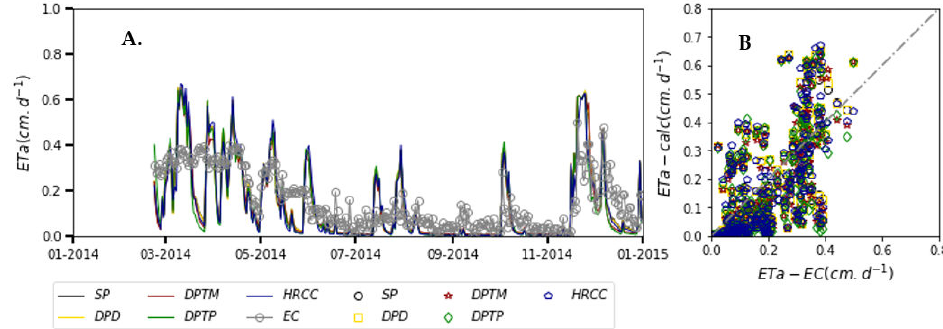
Figure 10. Comparison between the ETa estimated by the models ( A ) and the measurement by eddy covariance ( B ) in the Caatinga area.